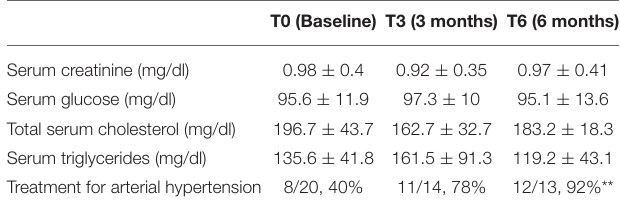
TABLE 2 | Laboratory parameters and antihypertensive treatment in the patients